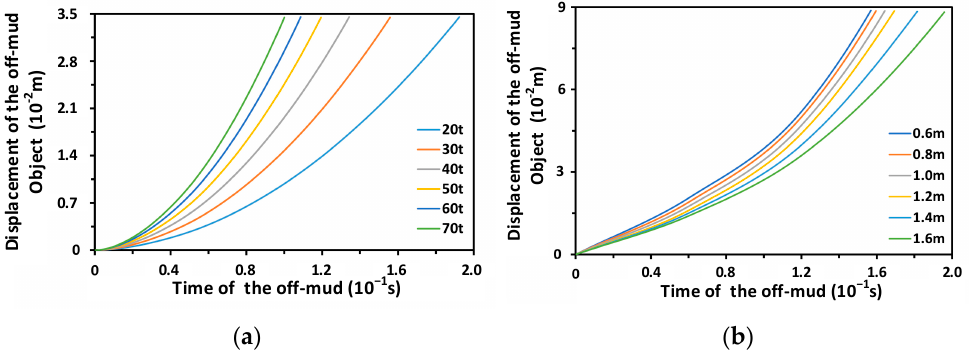
Figure 17. Displacement with different lifting forces and burial depths: ( a ) burial depth, 1.6 m; ( b ) lifting force, 50 t.